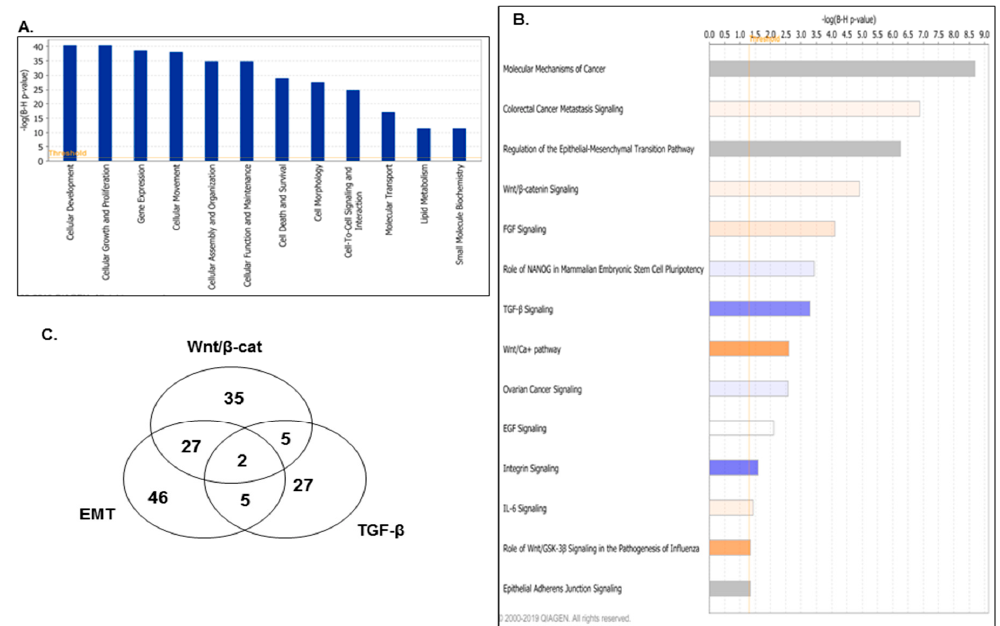
Figure 3. Ingenuity pathways analysis (IPA) of the 6666 common hyper- and hypomethylated genes in SKOV3-E cells. ( A ) Functional analysis for a dataset of the common hyper- and hypomethylated genes. Top functions that meet a Bonferroni–Holm multiple testing correction p -value of 0.05 are displayed. ( B ) List of selected canonical pathways that were significantly altered in SKOV3-E cells. Top functions that meet a Bonferroni–Holm multiple testing correction p -value of 0.05 are displayed. ( C ) Venn diagram analysis displaying common genes between the EMT, Wnt/ β -catenin, and TGF- β signaling pathways, as derived from the IPA canonical pathways analysis.